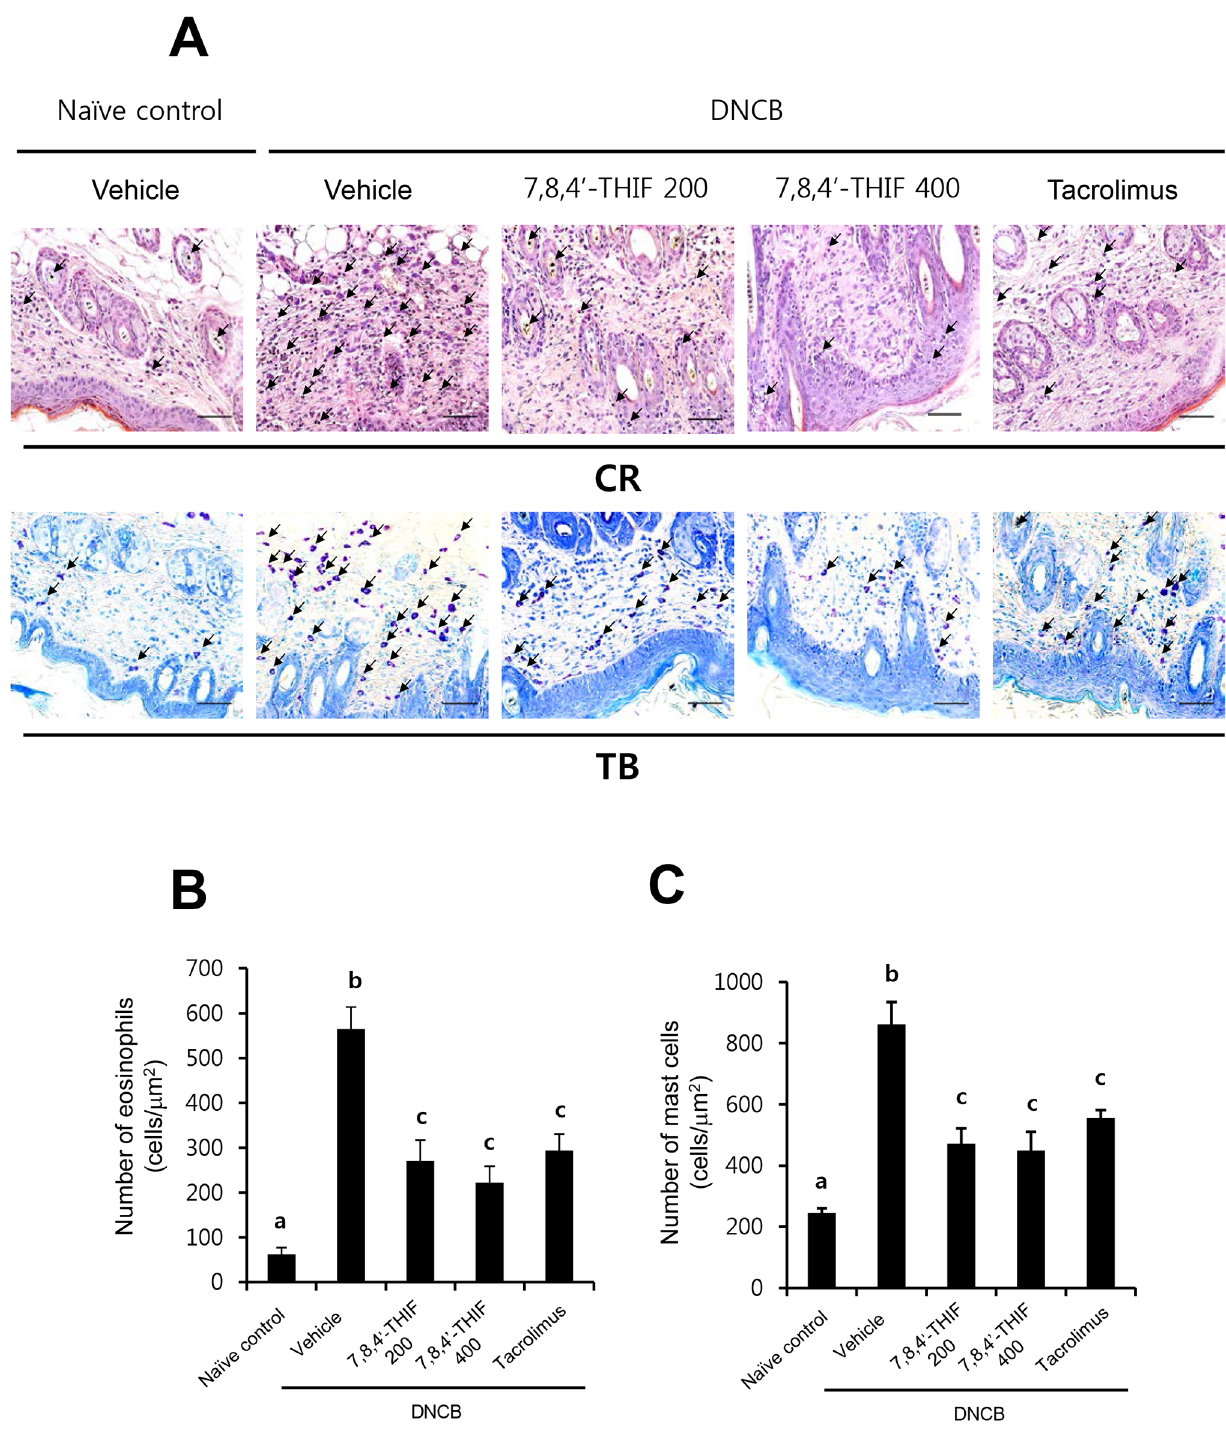
Figure 4. Effect of 7,8,4 9 -THIF on DNCB-induced eosinophil and mast cell infiltration in skin lesions of NC/Nga mice. (A) Representative images depicting the histological features of skin collected on day 21 are shown. Congo red (CR) and toluidine blue (TB) staining were used to identify eosinophils and mast cells, respectively. The arrows indicate the CR-stained eosinophils and the TB-stained mast cells. Cells were counted under a microscope at 400 6 magnification. The numbers of (B) eosinophils and (C) mast cells in 1 m m 2 of skin were calculated. Data represent the mean 6 SEM (n=9). Means with letters (a–b) within a graph are significantly different from each other at p , 0.05.